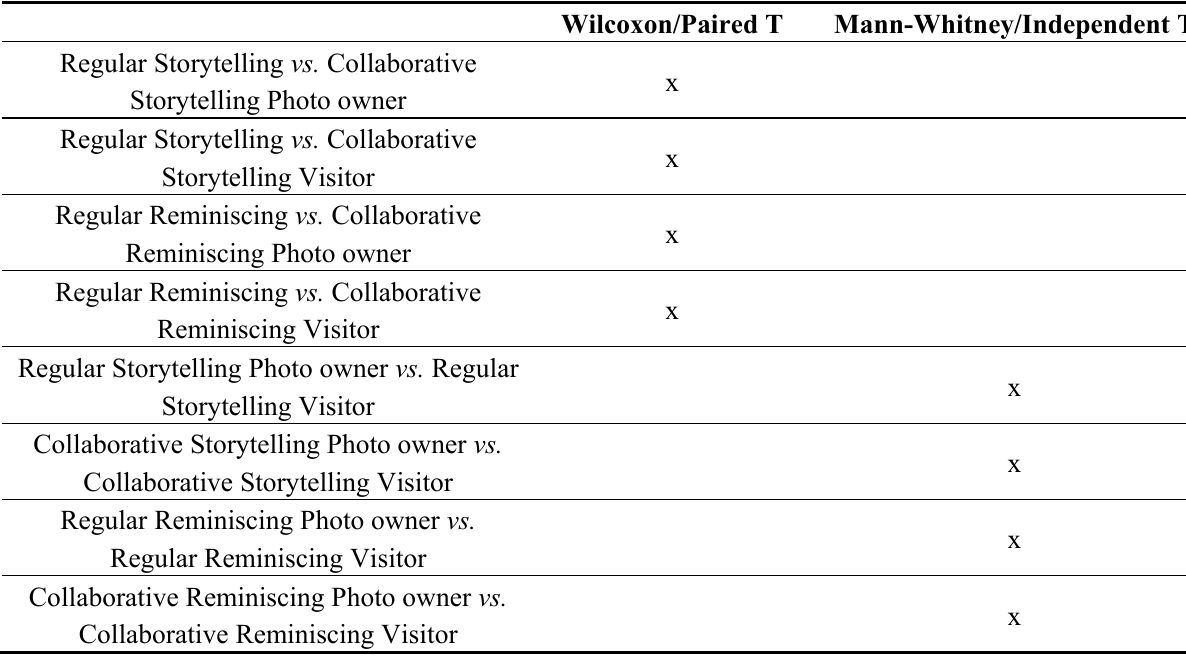
Table 3. Test methods used for comparing different conditions. The Wilcoxon Signed Rank Test and the Mann-Whitney U Test were used for the non-parametric data (the questionnaires), while the paired-samples t -test and the independent samples t -test were used for parametric data (the observed